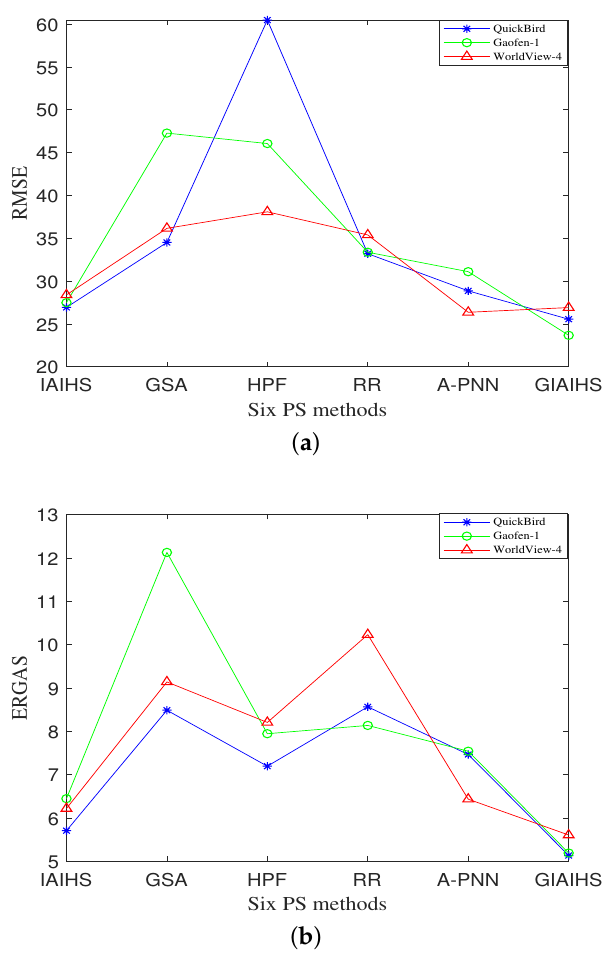
Figure 8. RMSE and ERGAS evaluation results of GIAIHS method and five other methods in three groups of different satellite data of QuickBird, Gaofen-1 and WorldView-4. ( a ) RMSE results. ( b ) ERGAS